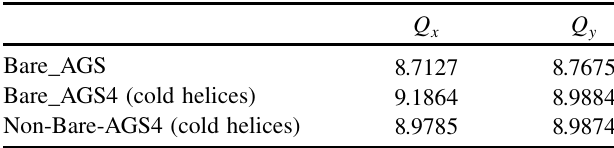
TABLE II. The horizontal and vertical betatron tunes ð Q x ; Q y Þ for three different setups of the AGS, as they appear in the 1st column.